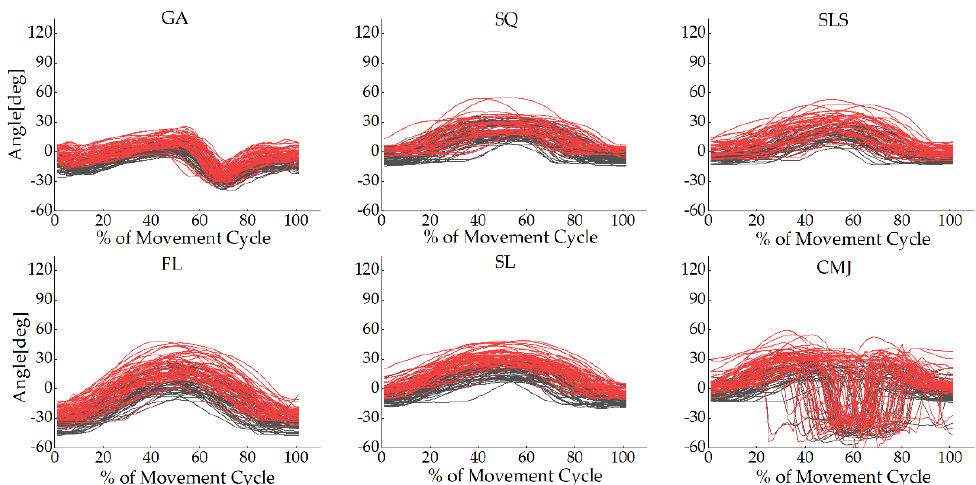
Figure 4. Ankle joint angles in the sagittal plane for each participant in all tasks during the movement cycle of the gait (GA), squat (SQ), single-leg squat (SLS), side lunge (SL), forward lunge (FL), and counter-movement jump (CMJ). The black lines represent the OptiTrack system, while the red lines represent the Perception Neuron ® system. The Y -axis depicts joint angles in degrees, while the X -axis depicts the movement cycle in %.